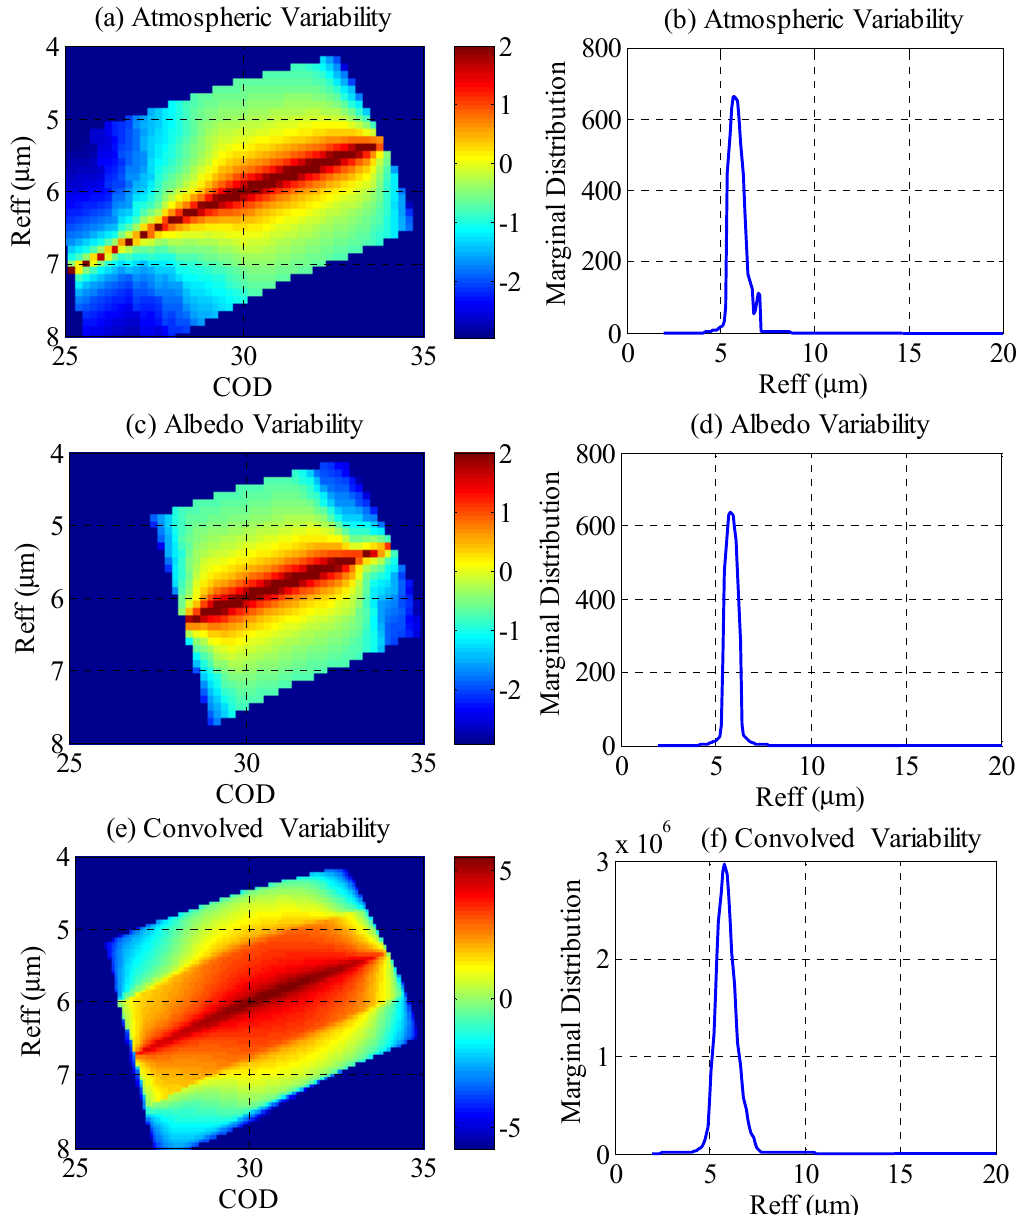
Figure 9. 2D distributions (left panel) and respective 1D distributions integrated over the CODs (right panel) for atmospheric variability ( a , b ), surface albedo variability ( c , d ), and convolved variability ( e , f ) of both variable